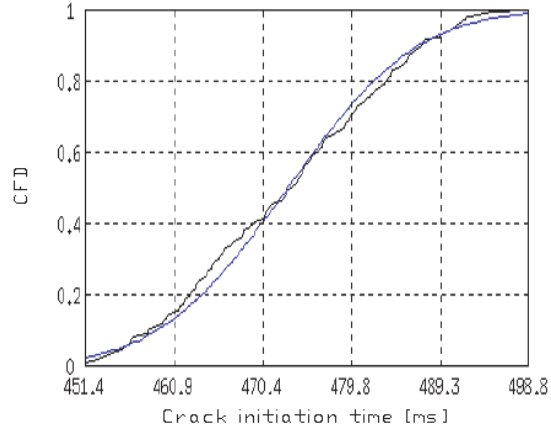
Figure 6: CFD of the crack init. time